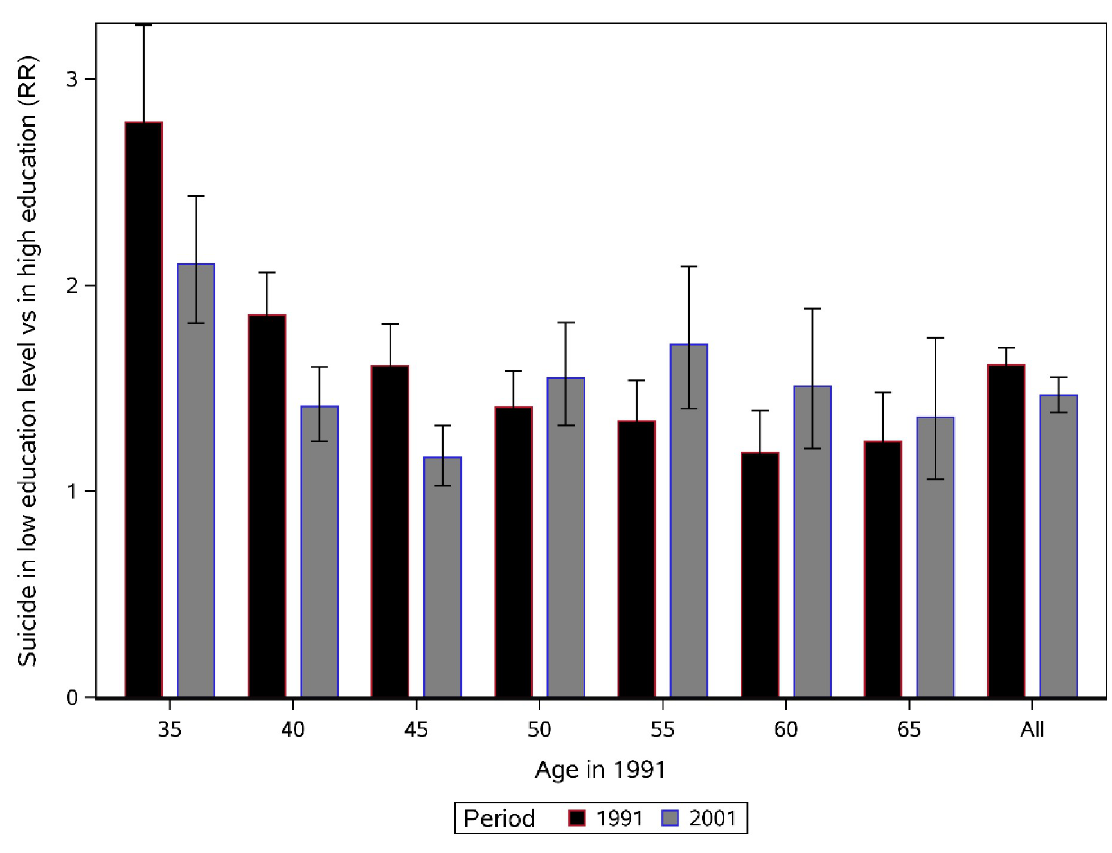
Fig 2. Educational disparities in suicide across age groups and period: Rate ratio of suicide, pooled and weighted Poisson regression analysis of Denmark, Finland, and Norway, 1991–2001.